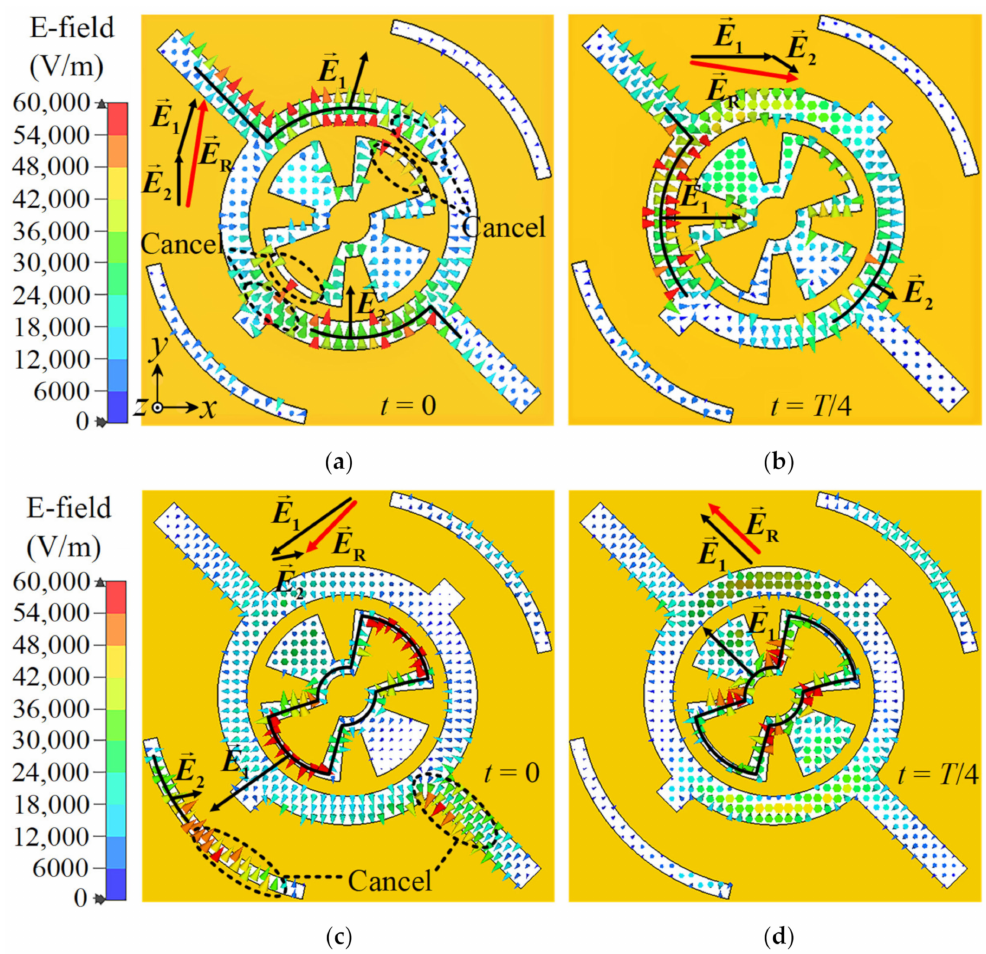
Figure 5. The distributions of the E -fields across the dielectric-loaded MCF slot: ( a ) 27.5 GHz at t = 0; ( b ) 27.5 GHz at t = T /4; ( c ) 41 GHz at t = 0; ( d ) 41 GHz at t = T